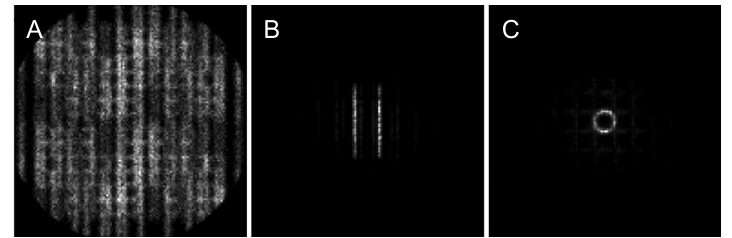
Figure 4. A , Simulated shadowgram projected on the detector by a set of two linear sources 10 mm from each other, located 50 mm from the detector, with a 10-mm outer diameter, 7-mm inner diameter ring located 60 mm from the collima- tor. B , Decoded image of the plane at 50 mm and C , at 60 mm. The presence of 21 intermediate planes, 45 to 65 mm from the collimator, was considered while image